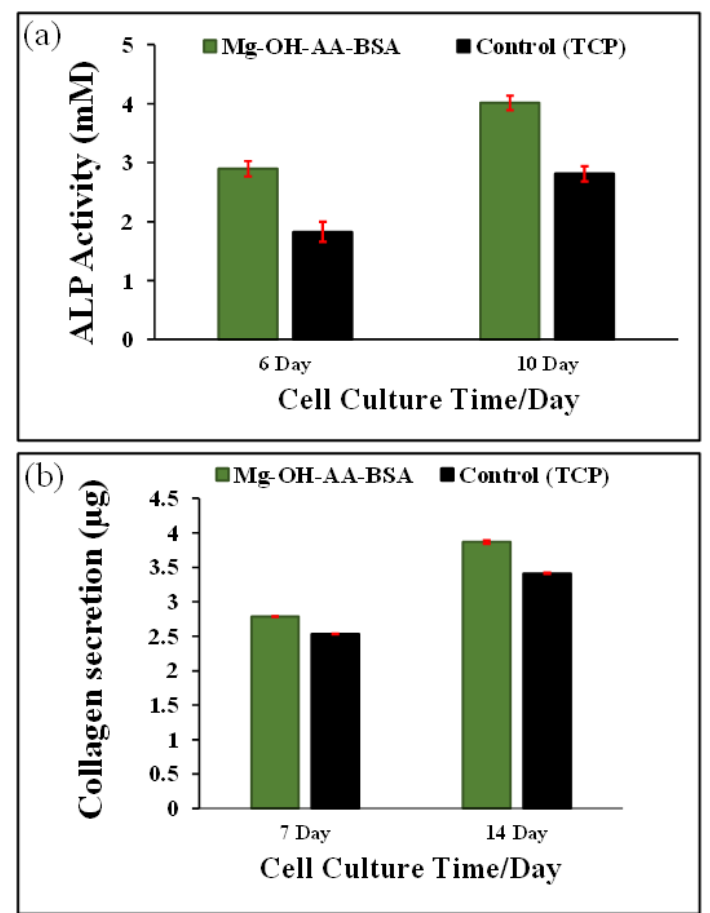
Figure 11. ( a ) and ( b ) ALP activity of MC3T3-E1 cells and expression of Type I collagen at various time periods, respectively.